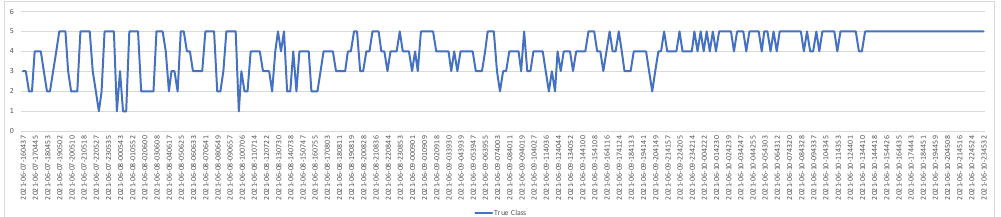
Figure 8. AP values for the first test dataset (IoU: 0.5–0.9).